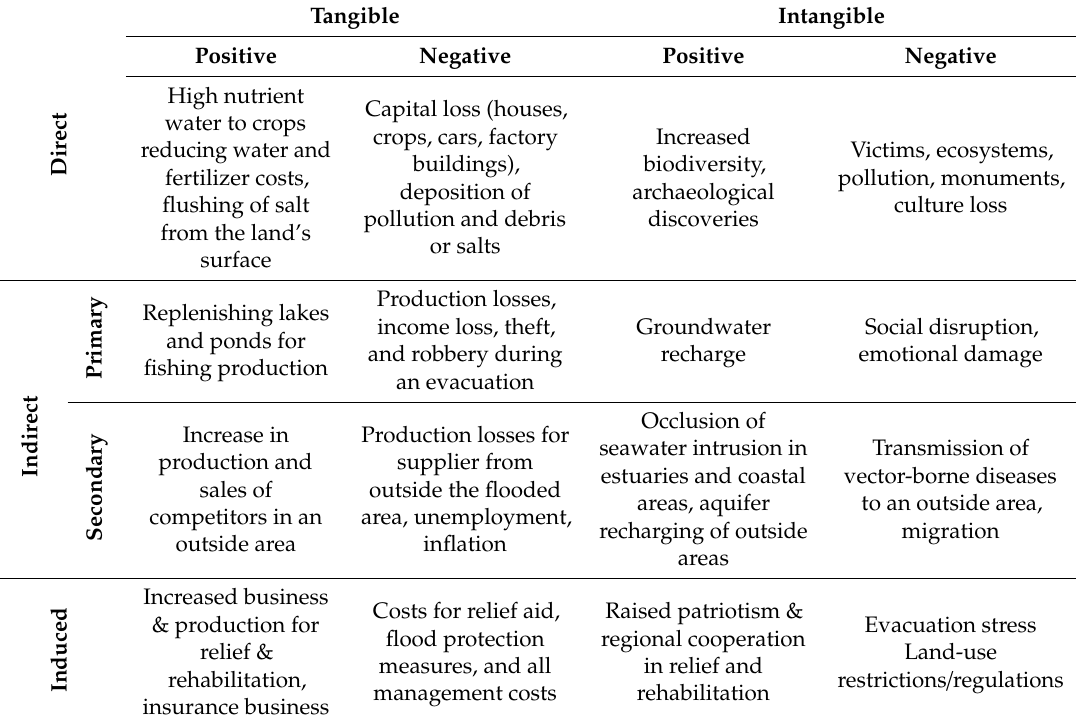
Table 2. Flood impact